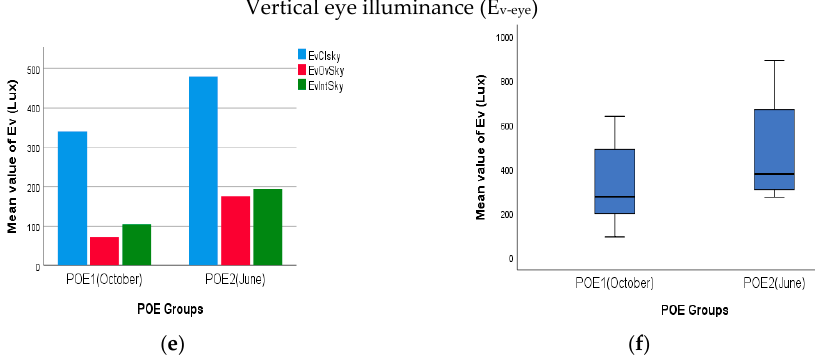
Figure 4. Overview of the results for the mean value of ( a ) horizontal illuminance of the calculated sensor points of the ten rooms’ areas at the work plane height (E h-room ), ( c ) horizontal illuminance on the task area of the calculated sensor points of the ten rooms’ areas (E h-task ), and ( e ) mean value of vertical illuminance in the center point of each room with viewing direction towards the daylight opening of the ten rooms (E v ) under three different sky conditions for 11 October and 4 June both for 10 a.m. ( a,c,e ). The details of the mean values under clear sky condition ( b , d , f ). Appl. Sci. 2021 , 11 , x FOR PEER REVIEW